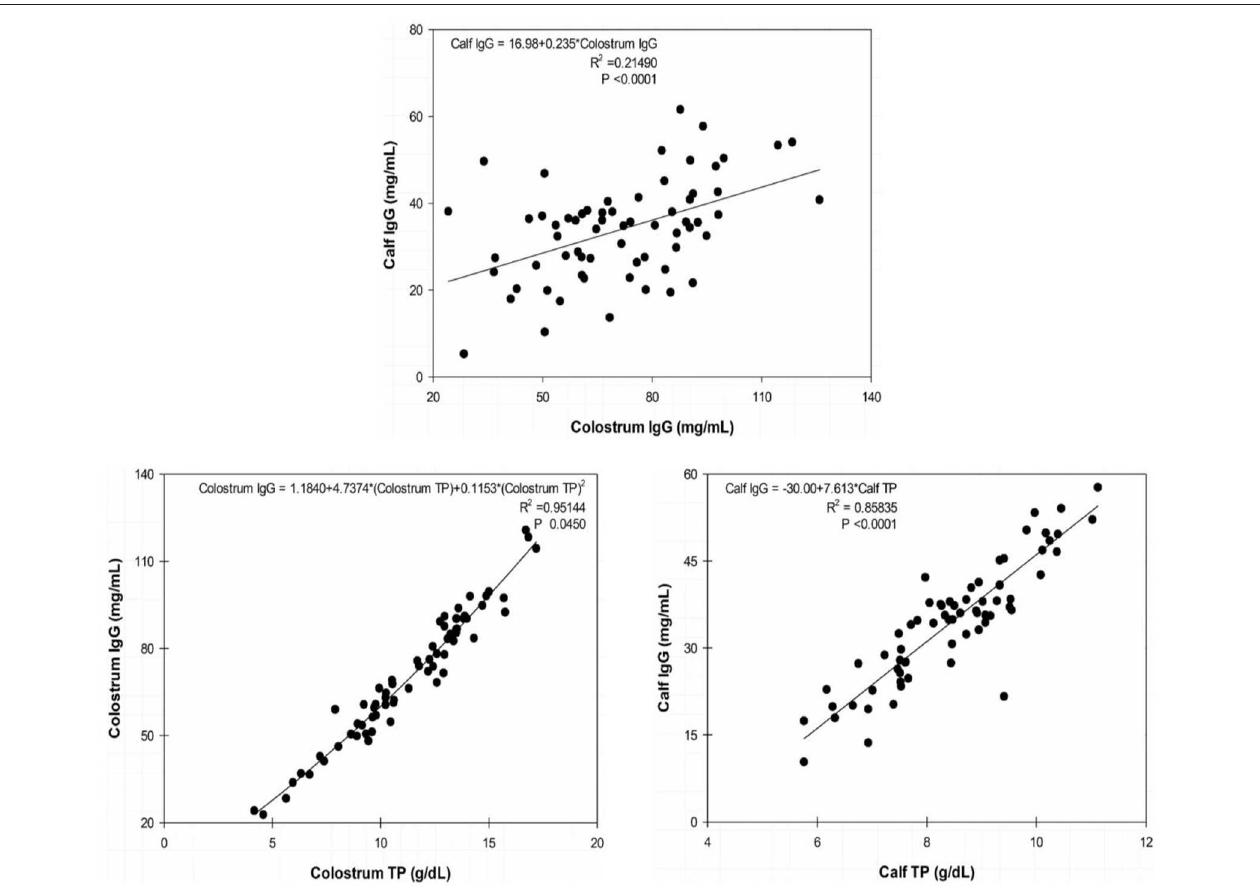
FIGURE 2 | Scatter plots of calf immunoglobulin (Ig)G at 24h × colostrum IgG at 0h; colostrum IgG × colostrum total protein (TP) at 0h; and calf IgG × calf TP at 24h. The line represents the tendency of the data determined by simple linear regression on calf blood serum and quadratic regression on dam colostrum.